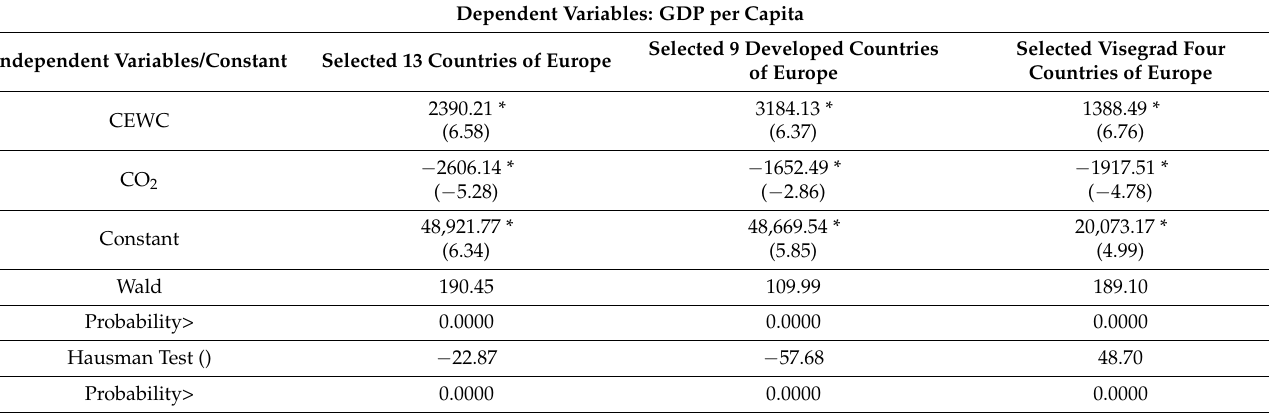
Table 4. Results of the Pooled Regression.